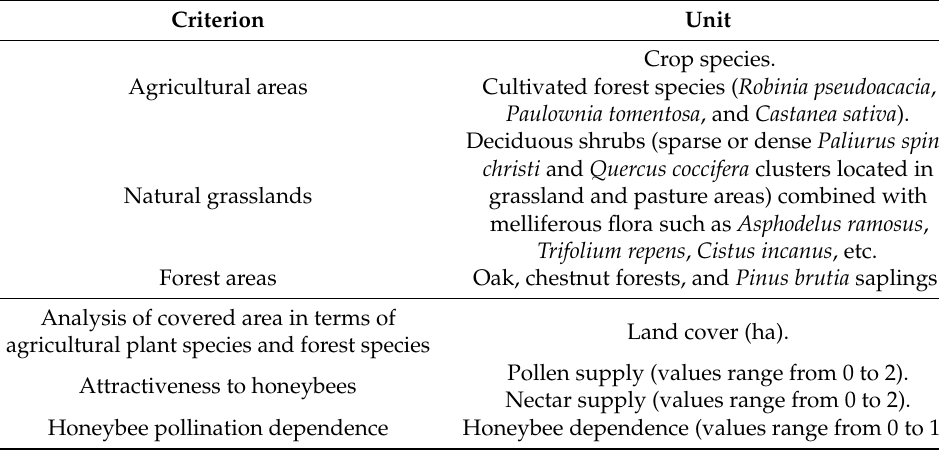
Table 1. Criteria for evaluating priority